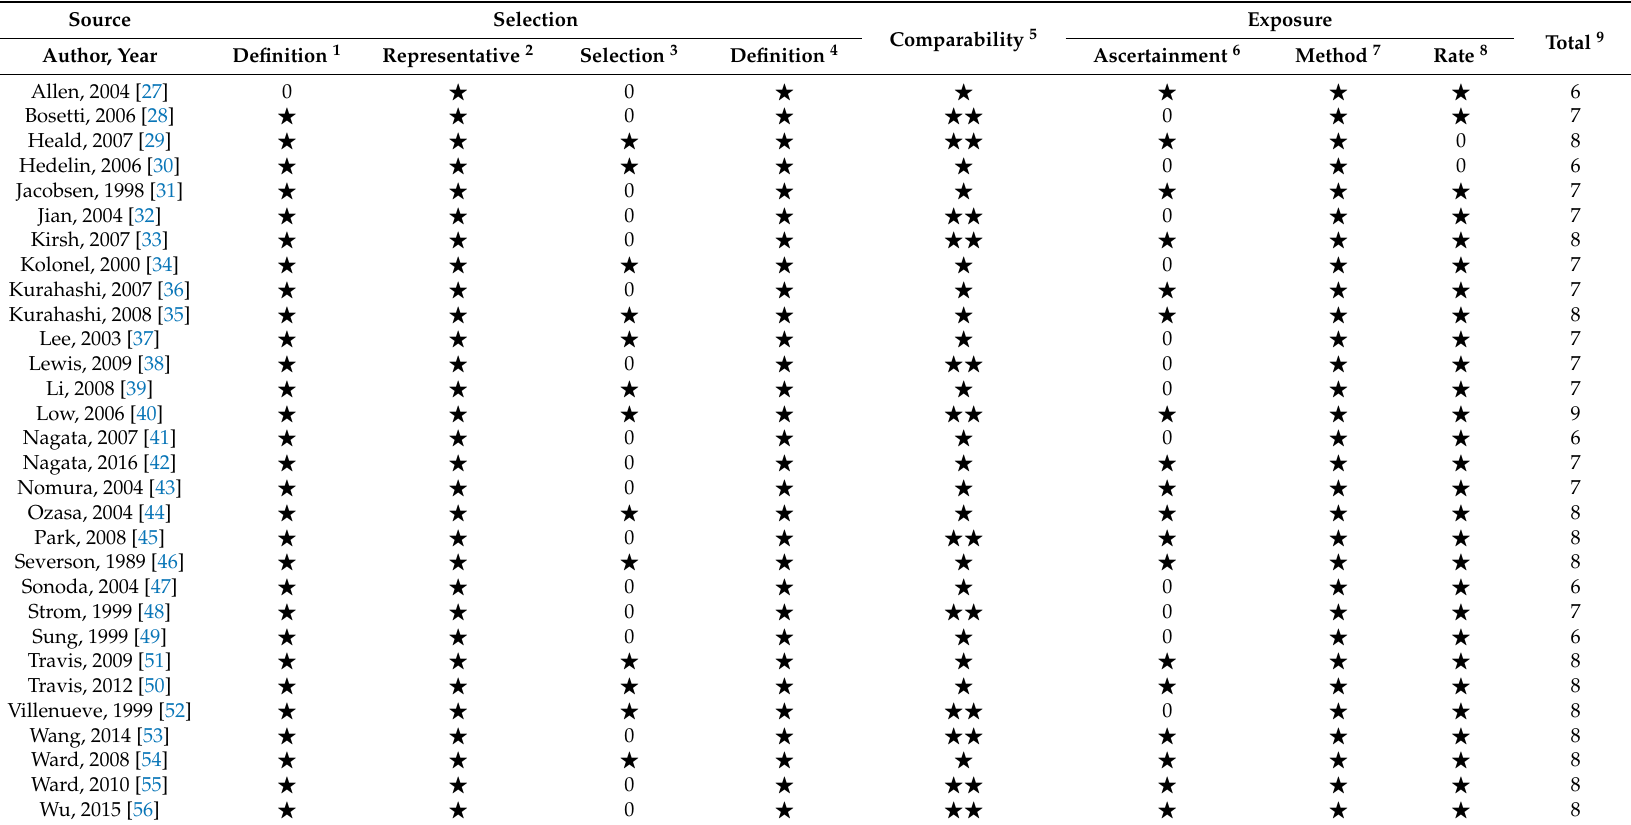
Table A1. Quality assessment of included